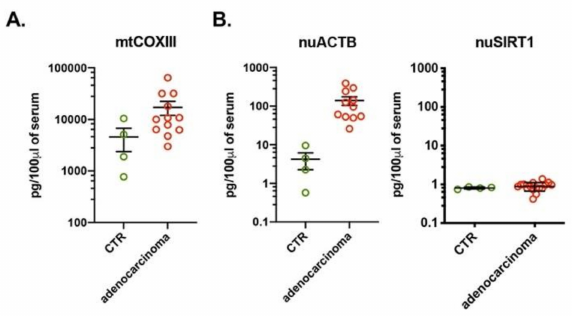
Figure 2. Subject with lung adenocarcinoma have high amount of ccf-DNA. The amount of mtDNA ( A ) and nuDNA ( B ) was quantified with qPCR using mtCOXIII and nuACTB and nuSIRT1 primers, respectively, in serum of healthy volunteers ( n = 4) and subjects with lung adenocarcinoma ( n = 12). The serum was obtained at UTMB clinics. The amount of DNA is expressed as pg of DNA in 100 µ L of